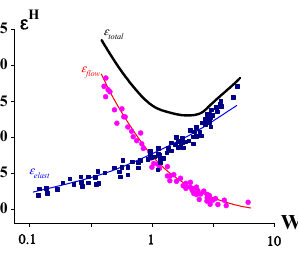
Figure 5. Dependences of the flow ( ε flow ) and elastic ( ε elast ) deformations on the Weissenberg number